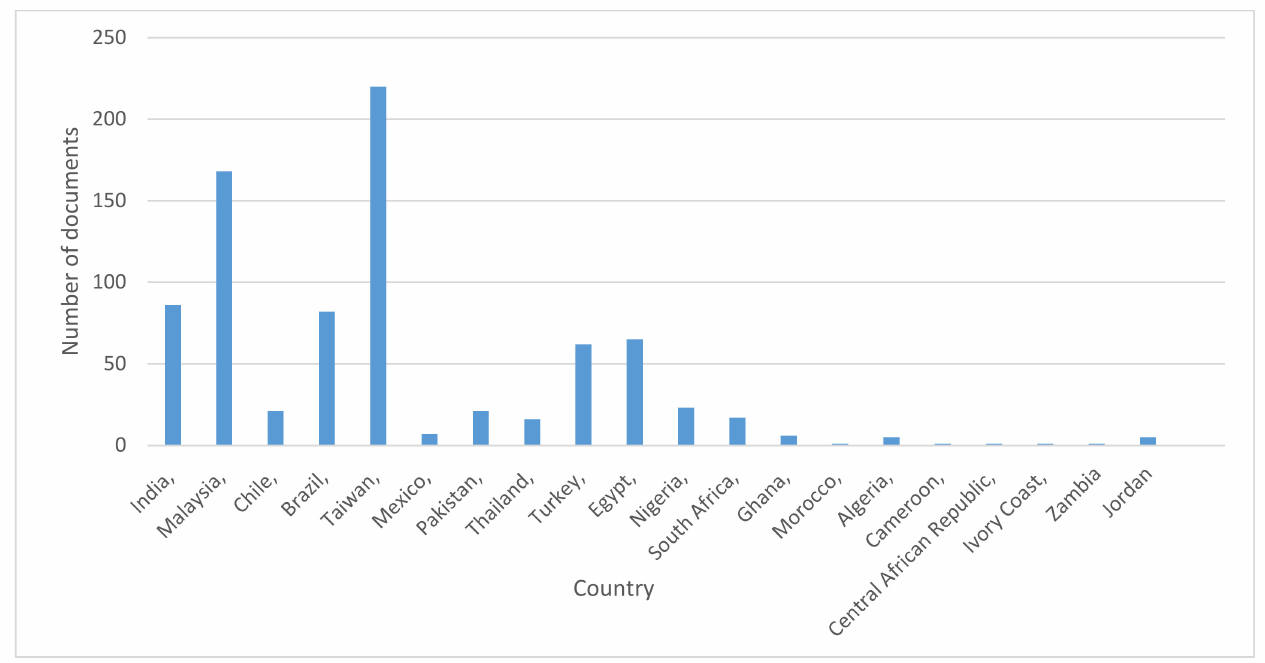
Figure 3. BIM scholarly publication in developing countries.